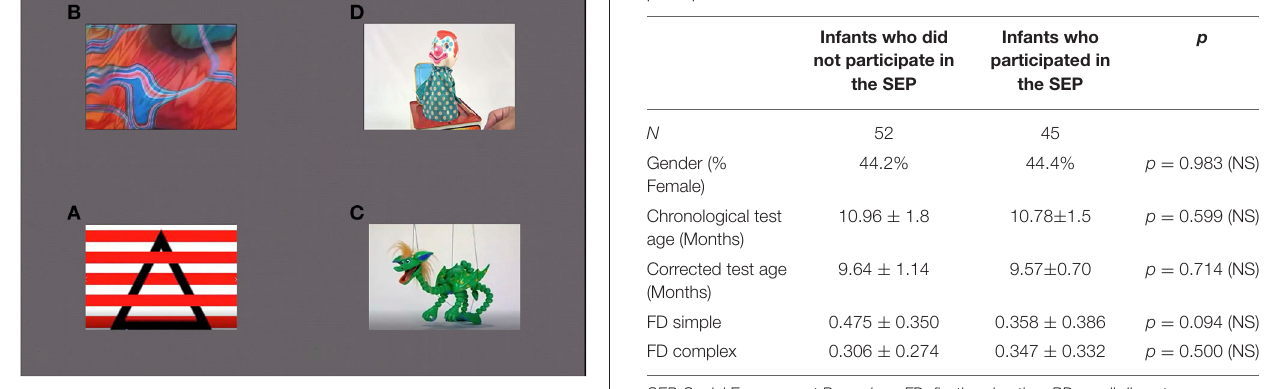
FIGURE 1 | GISP task images. The bottom left panel represents the simple stimulus, the top left panel represents the complex stimulus and the two right panels represent the semantic stimuli.